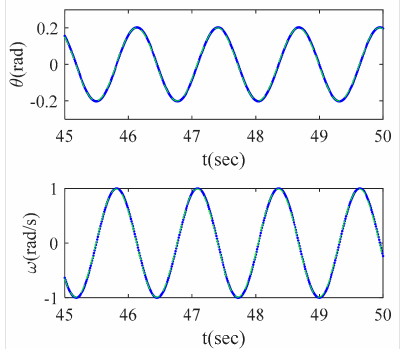
Figure 13. A comparison of the recursive method with the standard method.